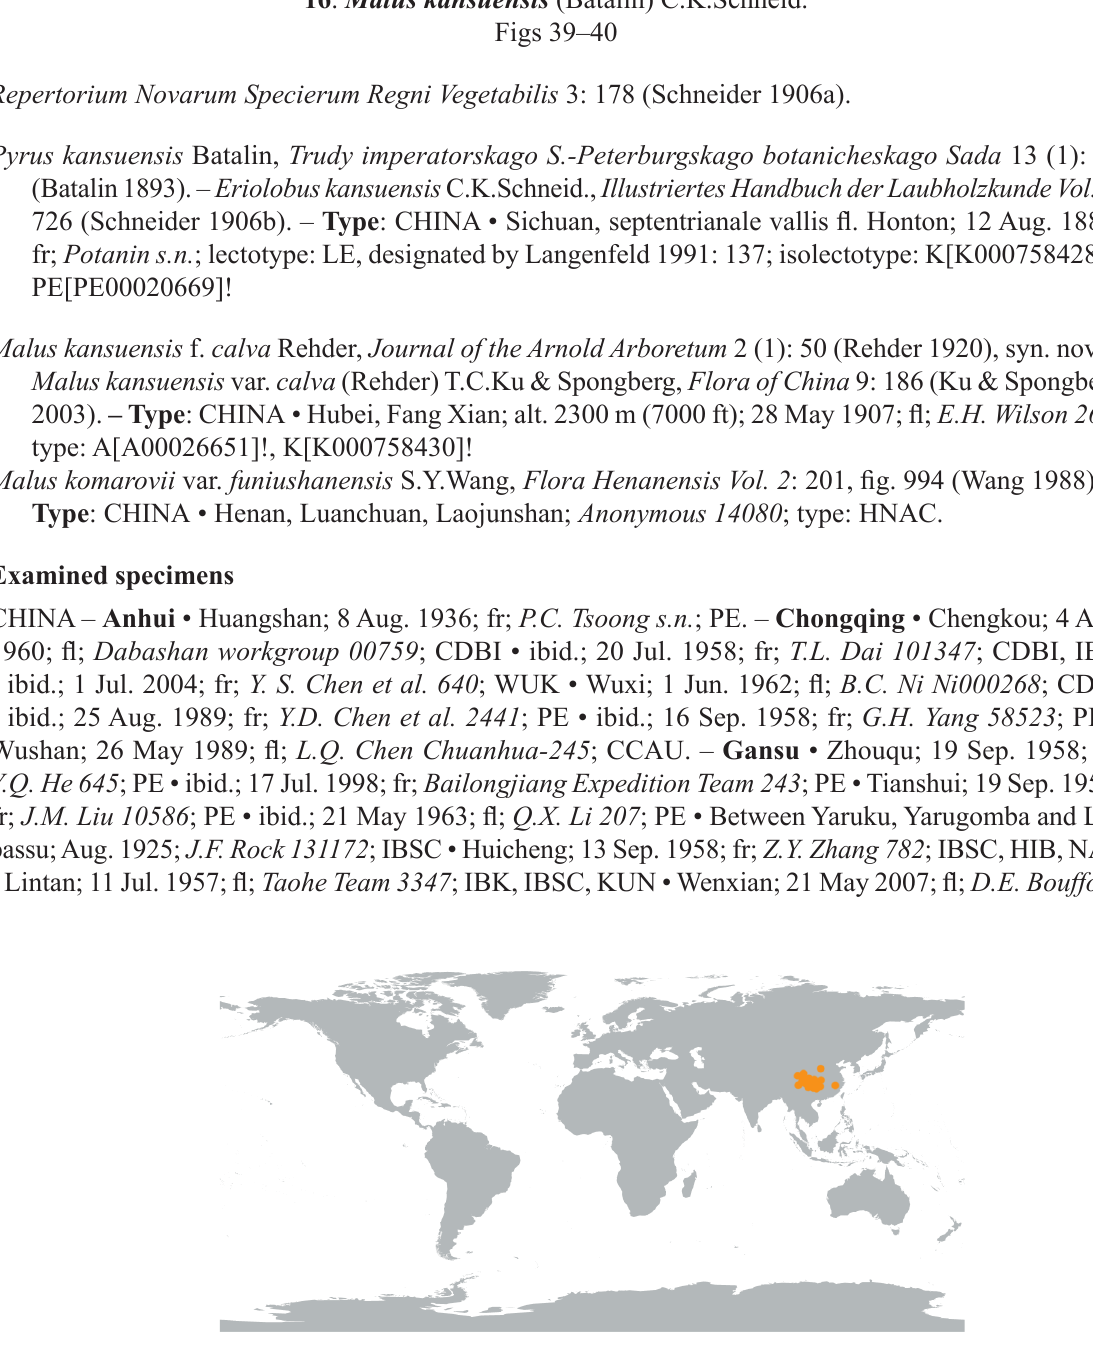
Fig. 39. Distribution of Malus kansuensis (Batalin)